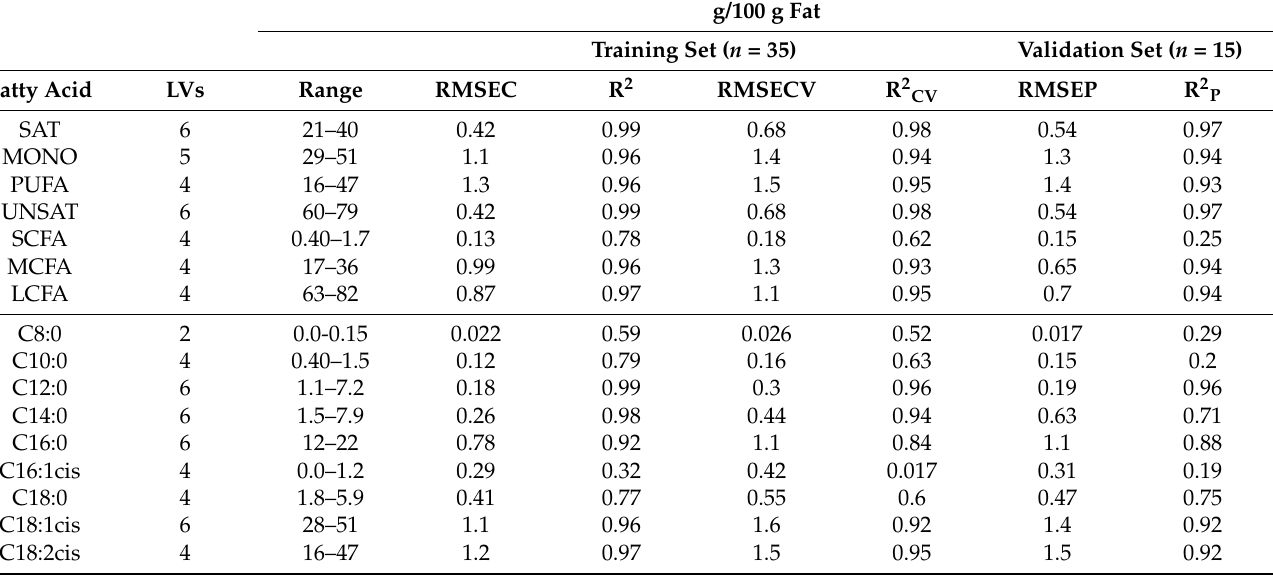
Table 1. Results of partial least squares (PLS) regressions for determining relative fatty acid concen- trations and sum parameters in g/100 g